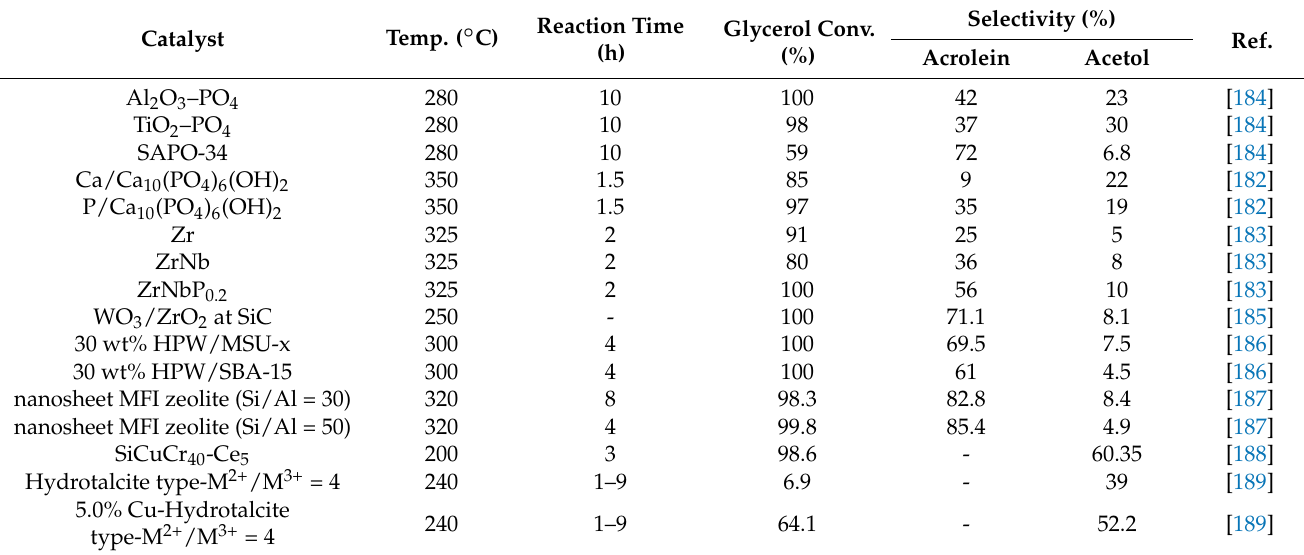
Table 7. Performance of different catalysts used in dehydration of